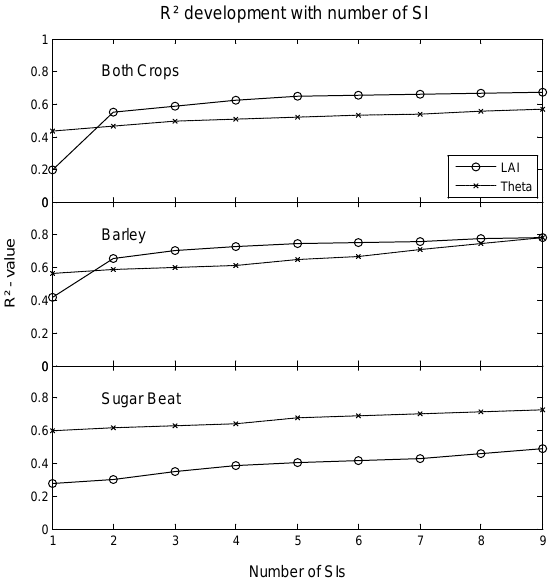
Figure 5. R 2 improvement within multiple linear regression analysis due to increase of explanatory variables for LAI (continuous line) and theta (discontinuous line) for both crops species together (top), (2) for barley (middle), and (3) for sugar beet